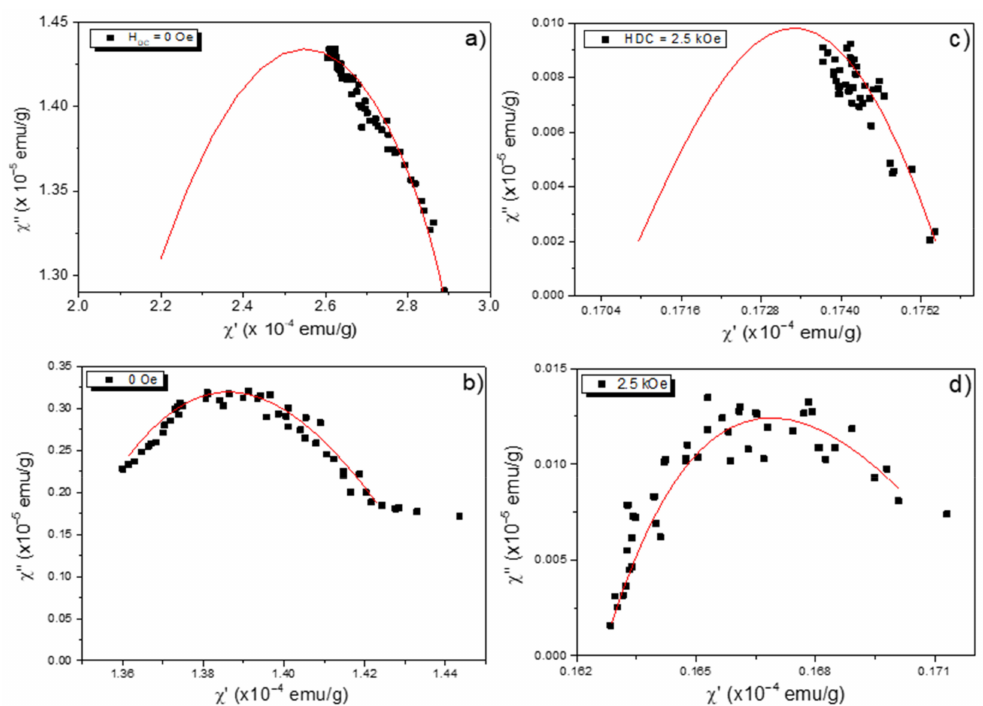
Figure 7. Argand diagrams recorded at 100 K (above) and 10 K (below) for zero applied ( a , b ) and DC field of 2.5 kOe ( c , d